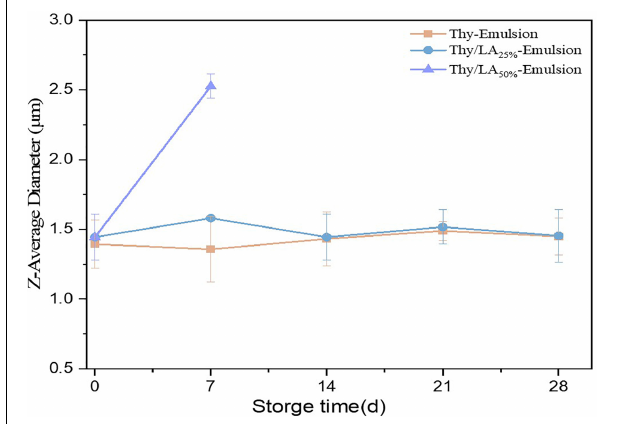
FIGURE 3 | Changes of the mean particle sizes of Thy/LA 25% -Emulsion, Thy/LA 50% -Emulsion, and Thy-Emulsion during storage for 4 weeks. As solidification appeared on the surface of Thy/LA 50% -Emulsion in the second week, particle size could not be measured. n =